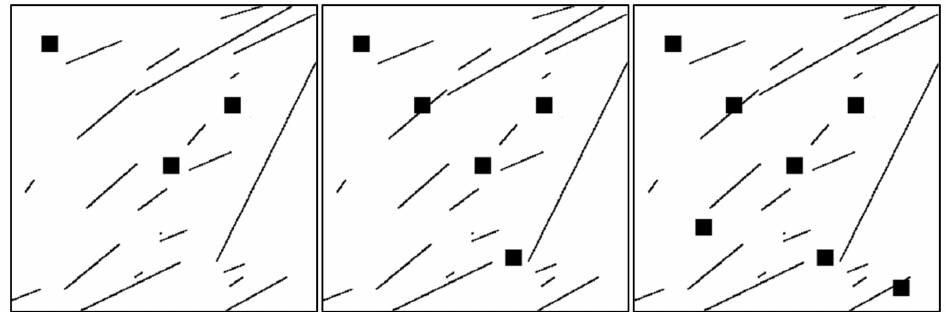
Figure 7. The fracture models with high fracture density and small vugs.